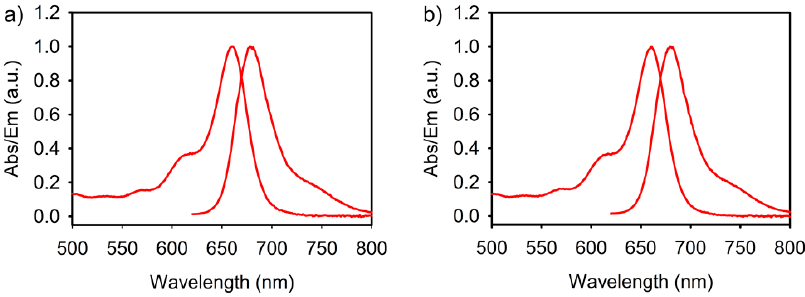
Figure 2. ( a ) The absorption and emission spectra of the Cy5-B in DMSO; ( b ) The absorption and emission spectra of the Cy5-BF 3 in DMSO. (Excitation (Ex) = 600 nm, Emission (Em) = 680 nm).